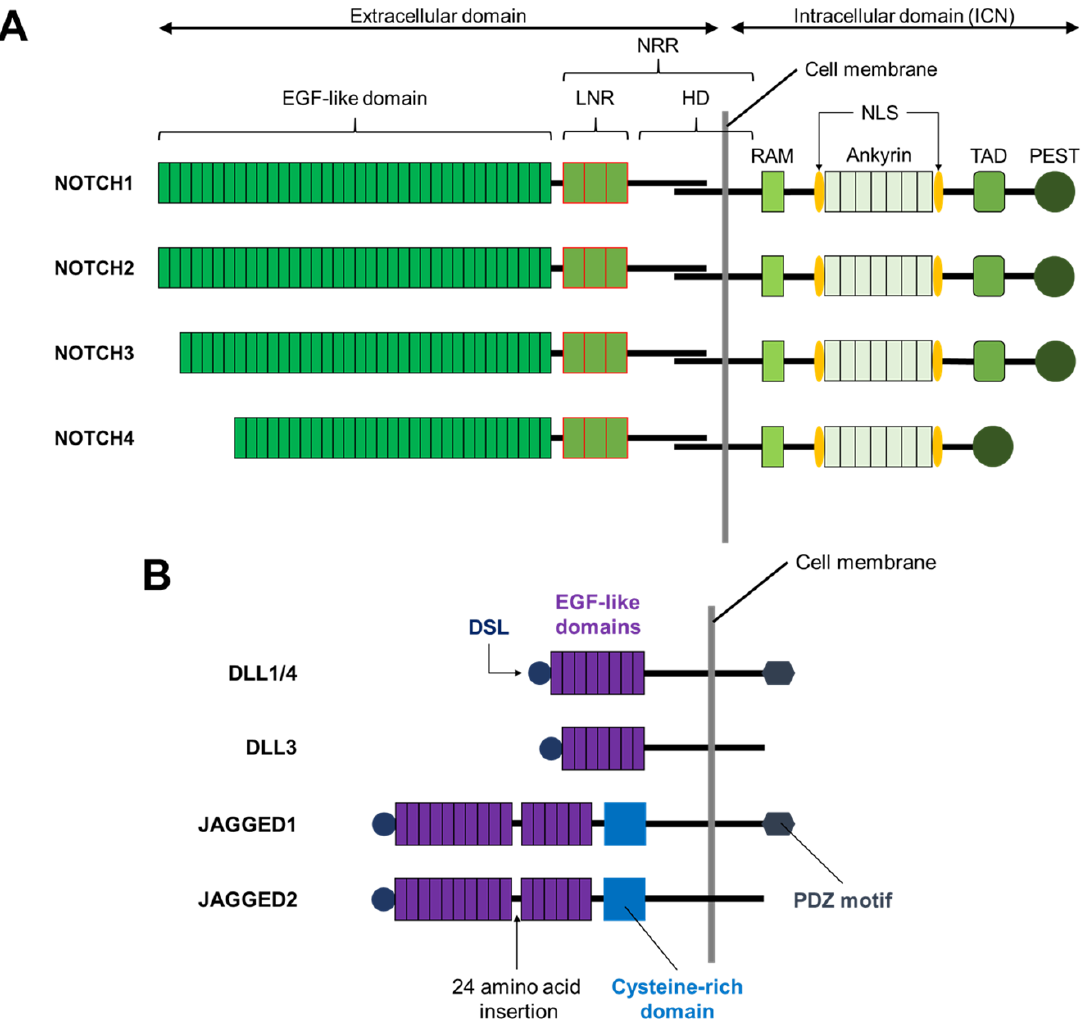
Figure 1. Structure of Notch receptors and ligands. ( A ) The four human Notch receptors (NOTCH1-4) are structurally similar. All receptors possess extracellular domains, and all four receptors share similarity in the intracellular domain, but NOTCH4 lacks the TAD domain. ( B ) All human Notch ligands of both the Delta-Like and Jagged families contain a DSL. The Notch ligand families can be distinguished by the number of EGF-like extracellular domains. Unique to the Jagged family is a 24 amino acid insertion between the 10th and 11th EGF-like domains of JAGGED1 and JAGGED2. The cysteine-rich region is another unique feature of the Jagged family ligands. At the C-terminus of DLL1, DLL4, and JAGGED1 is a PDZ motif. EGF: Epidermal growth factor; LNR: lin-12/Notch repeats; HD: Heterodimerization domain; NRR: Negative regulatory region; RAM: RBPjκ association module; NLS: Nuclear localization signal; TAD: Transcriptional activation domain; PEST: Proline (P), Glutamic acid (E), Serine (S), Threonine (T) rich domain; DLL: Delta-like; DSL: Delta/Serrate/LAG- 2 domain; PDZ: Post synaptic density protein (PSD95), Drosophila disc large tumor suppressor (Dlg1), and Zonula occludens-1 (ZO-1).